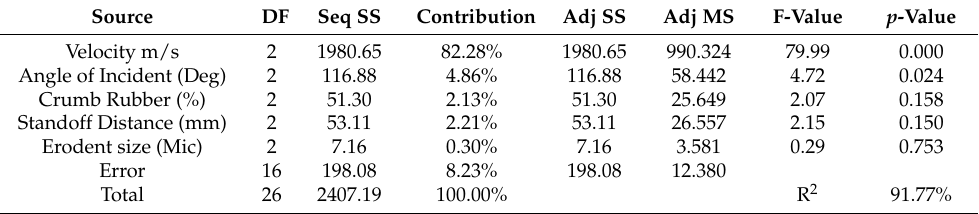
Table 5. Analysis of Variance for Transformed Response (Erosion